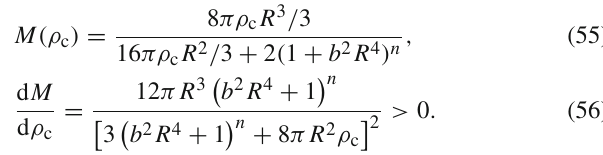
n = 12 exerts a higher outward pressure, the corresponding density is also smaller. The increasing nature of anisotropy is shown in Fig. 4; n = 12 shows smaller anisotropy than n = 24. This anisotropy is zero at the center since the mat- ter is highly packed. The mass function and compactness parameter are shown in Fig. 5 signifying that the maximum mass is 2 . 1 M (cid:2) and the maximum compactness